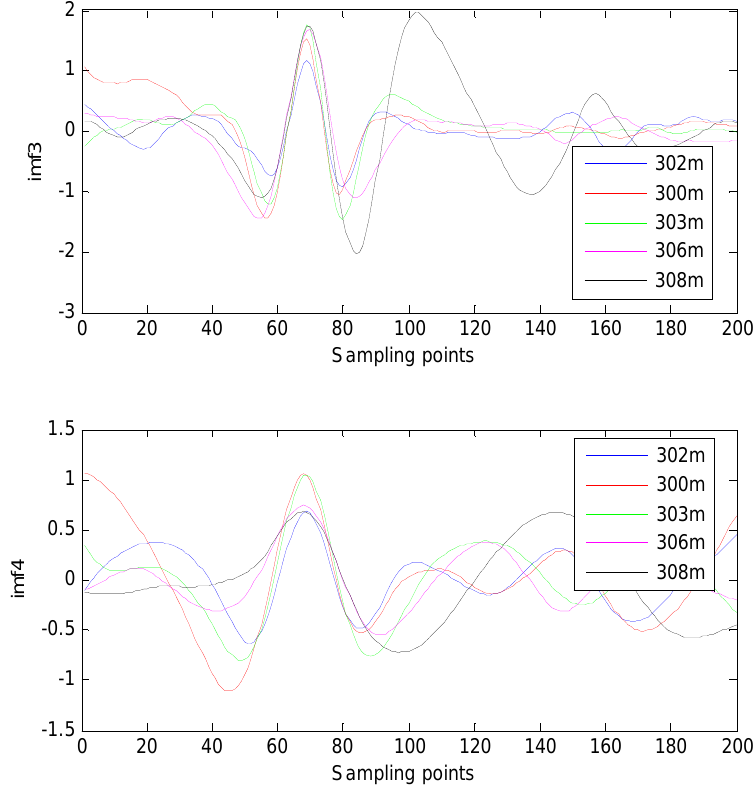
Figure 17. Waveforms of IMF 3 and IMF 4 from different ECG records.